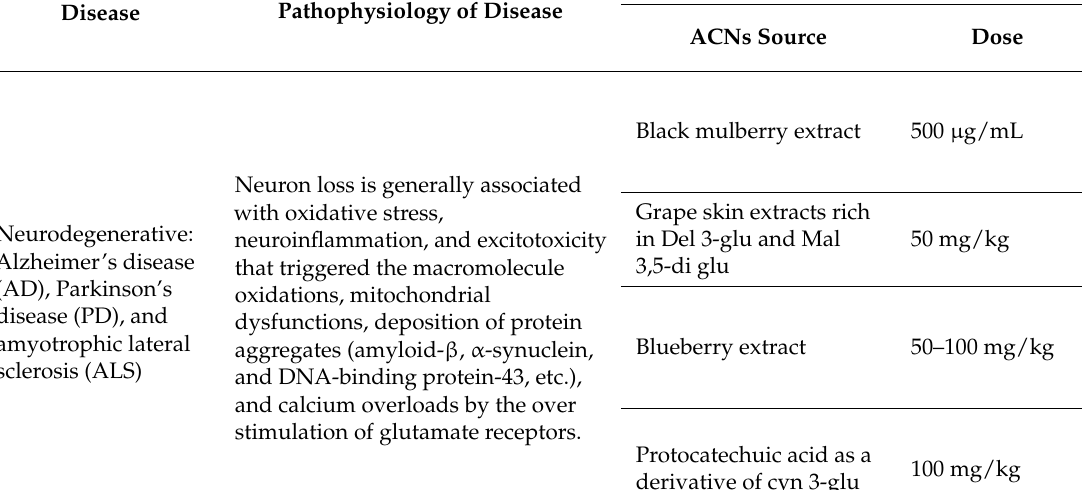
Disease Pathophysiology of